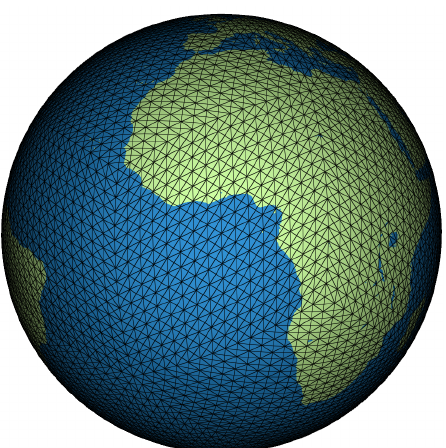
Figure 17. DT subdivided to resolution 5. The angular distortion along edges is not visible.